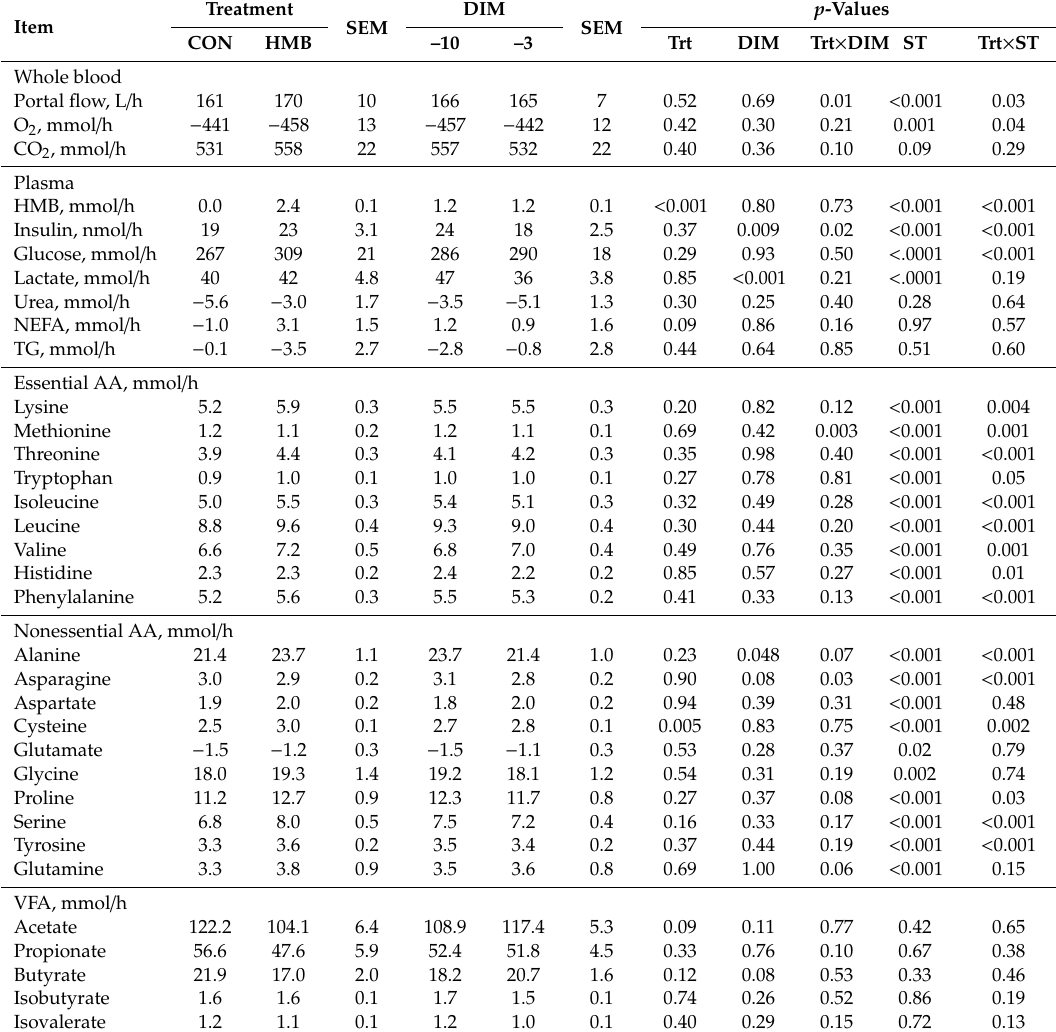
Table 4. Blood and plasma flow, and net portal fluxes of gases and metabolites in control (CON) and HMB-supplemented (HMB) sows during late